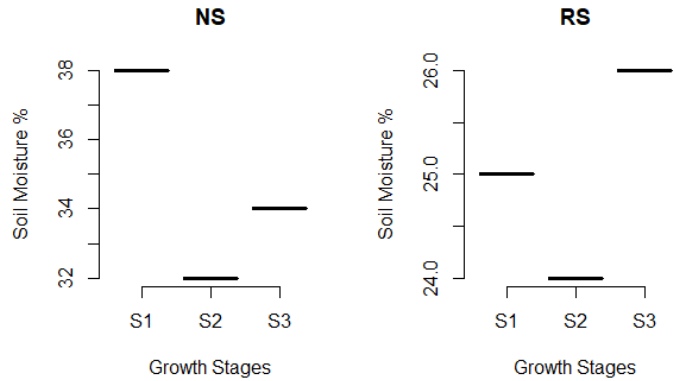
Figure 1. Soil moisture content in non-stress (NS) and drought stress (RS) plot. S1: Early reproductive, S2: Reproductive, S3: Maturity.